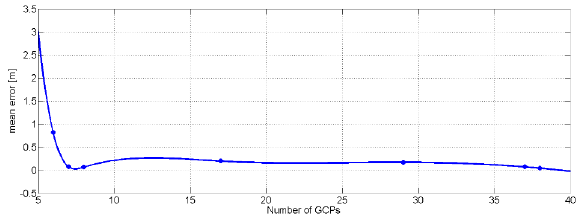
Figure 9: The best overall accuracy can be reached with 7 or 8 GCPs. A higher number is not necessarily needed for accuracy